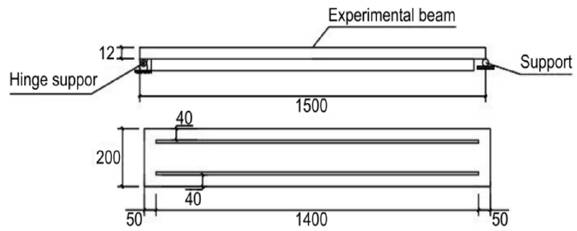
Figure 3. Schematic diagram of models under stiffening conditions.